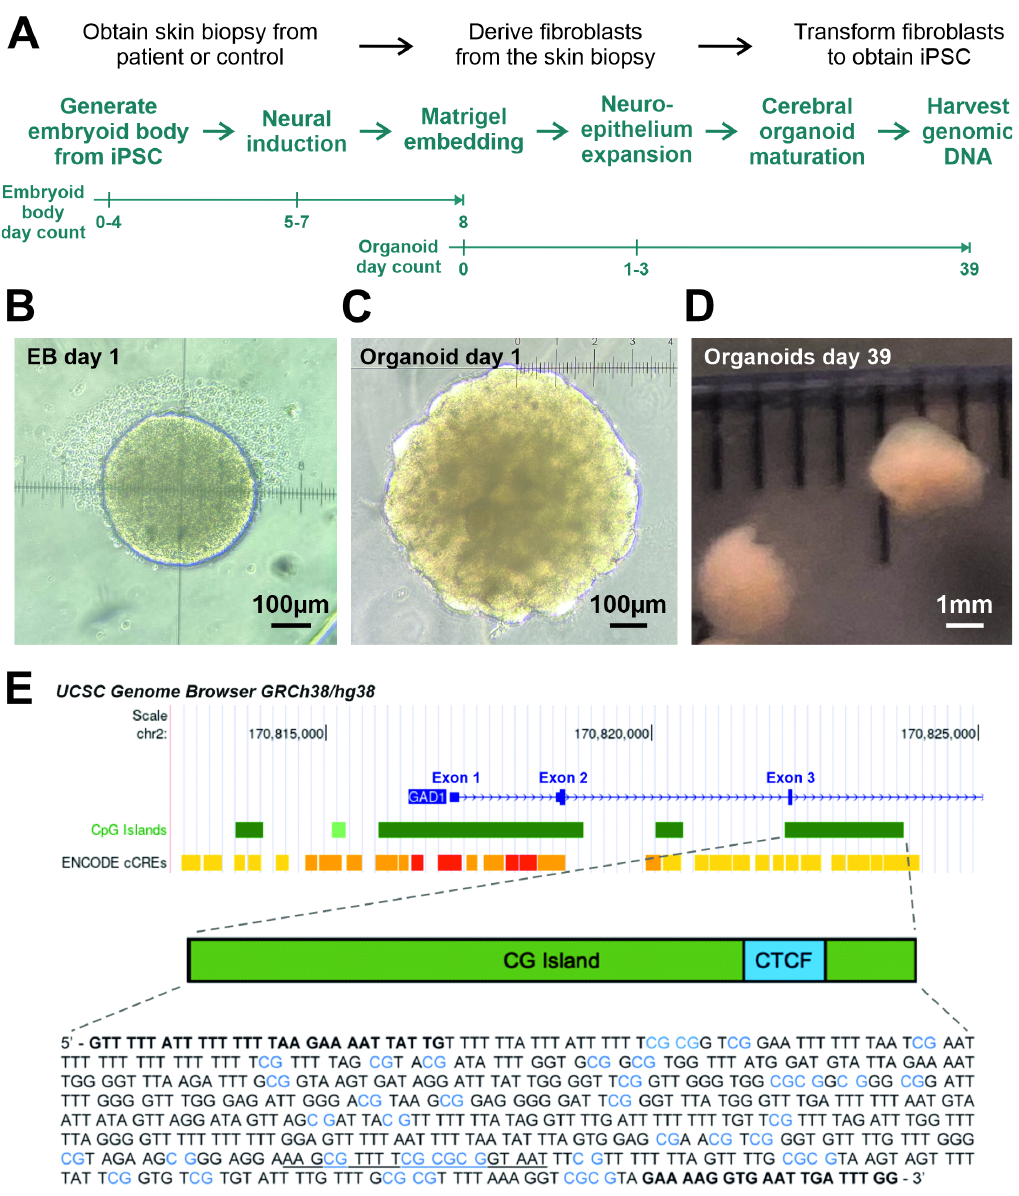
Figure 1. Organoid production stages and human GAD1 gene target region. ( A ) The production of human-derived organoids follows two main stages. Upper: Using subject skin biopsies to generate human inducible pluripotent stem cells. Lower: Using the inducible pluripotent stem cells to produce the embryoid body, which will then develop into brain organoids. ( B ) Example image of an embryoid body at embryoid body (EB) day 1. ( C ) Example image of a brain organoid at organoid day 1. ( D ) Example image of brain organoids at organoid day 39, when the genomic DNA is harvested for GAD1 methylation profiling. ( E ) The human GAD1 target region for the methylation analysis mapped onto the UCSC genome browser (assembly GRCh38/hg38, https://genome.ucsc.edu/ (accessed on 30 April 2022) [26,27]). We profiled a CTCF binding-site-containing CpG island that has been shown to correlate with GAD1 gene transcription in human cells [24]. Sequence shown is specific to bisulfite-converted DNA, with the 39 sites of potential CpG methylation highlighted in blue. Underlined region denotes a CTCF binding sequence. Primer annealing regions used to amplify the region of interest are indicated in bold. Additional images and characterisation of subject-derived organoids can be found in